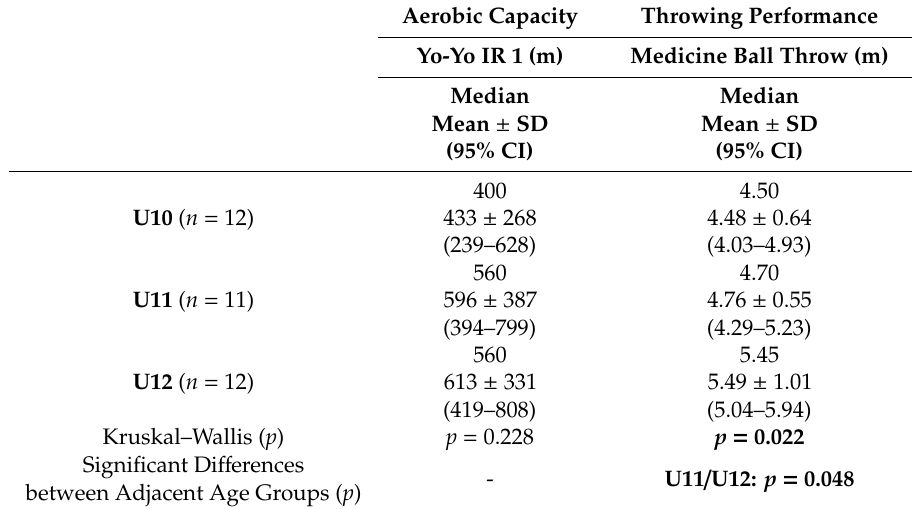
Table 4. Aerobic capacity measuring in the Yo-Yo IR1 and medicine ball throw in relation to age groups. Bold font denotes p <